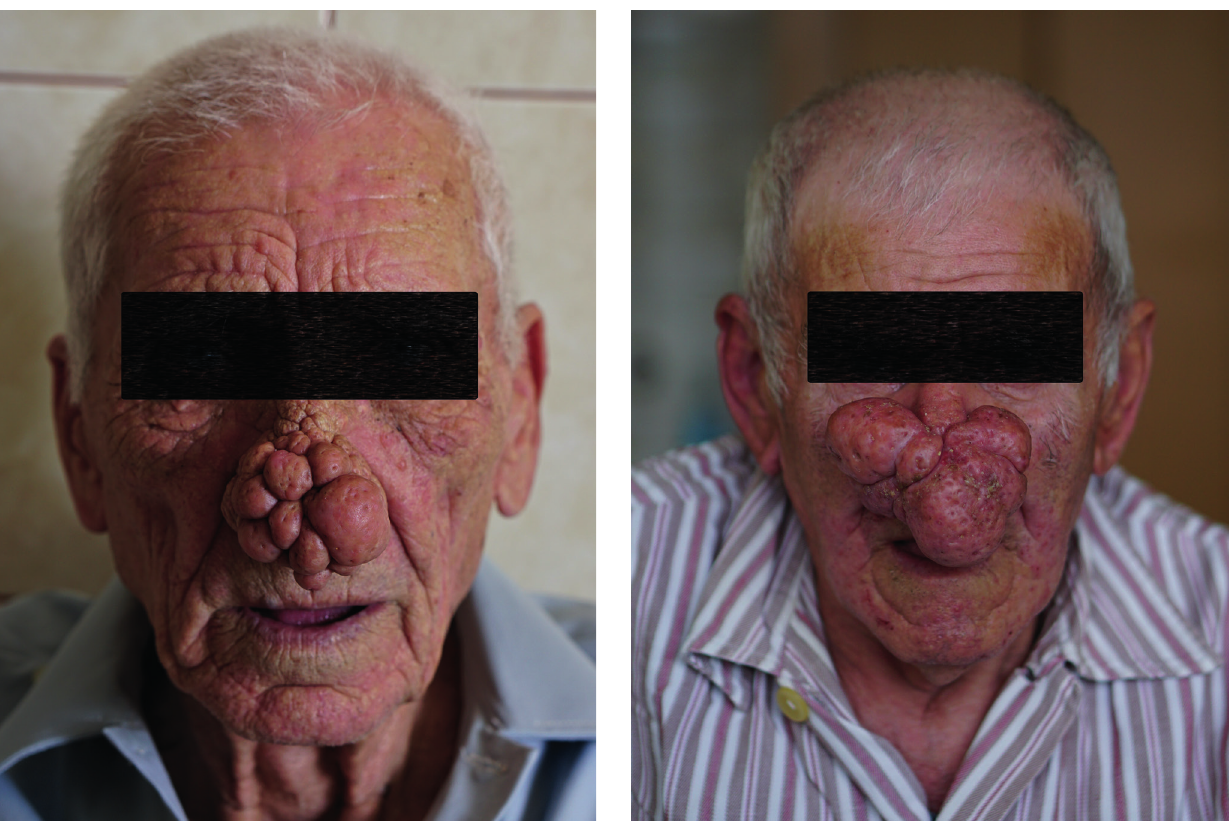
Figure 1. Patient №1 Preoperative view. Figure 2. Patient №2 Preoperative